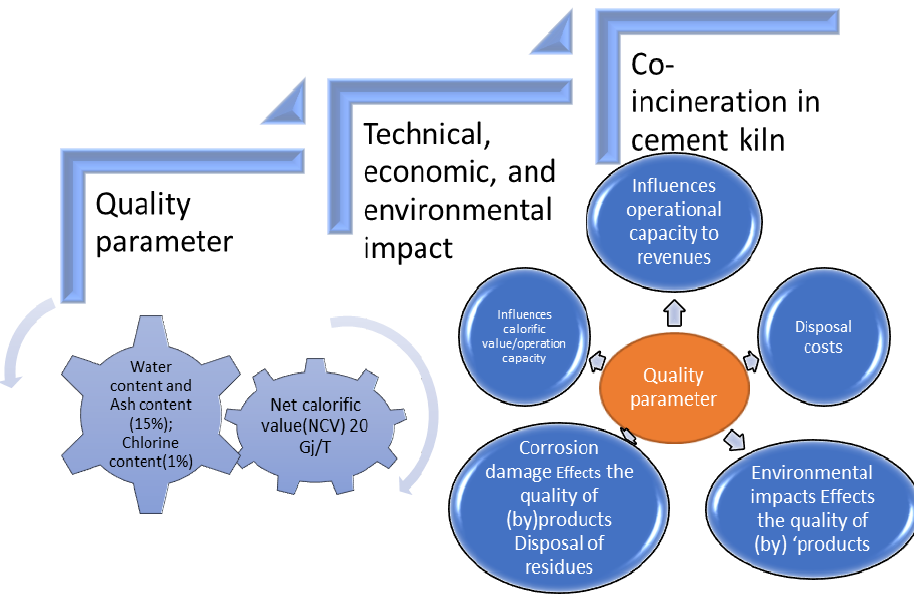
Figure 1. Refused derived fuel (RDF) characterizations for modern kiln.